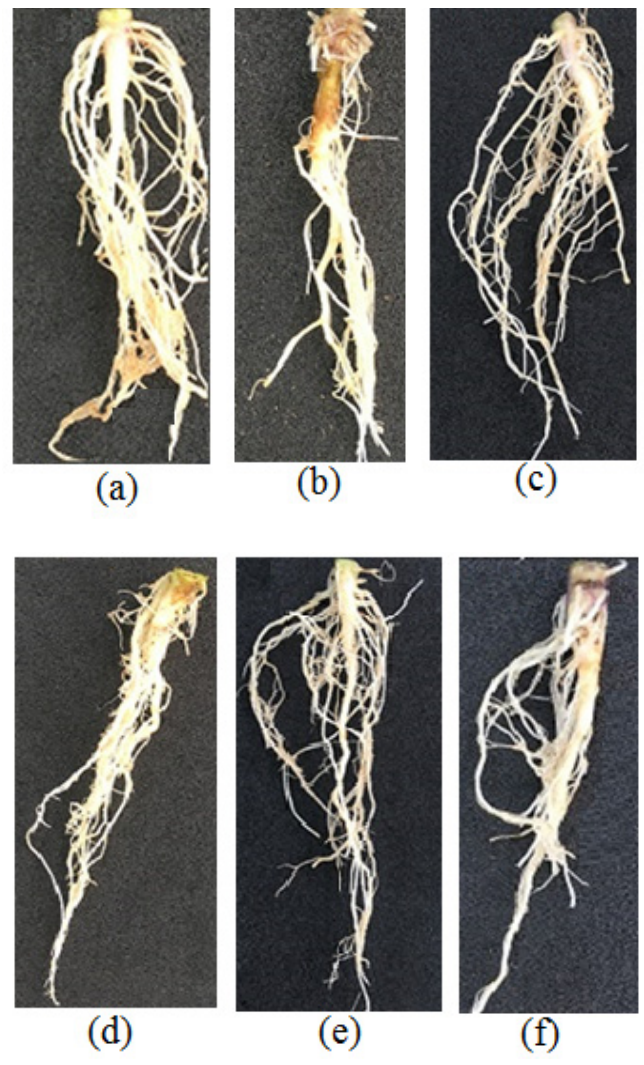
Figure 7. Comparative results of the biological activity of Streptomyces globisporus strain F8 and S. praecox strain R7 against R. solani AG4 on tomato seedlings at the 4th day after pathogen inoculation. ( a ): control treatment; ( b ): plant inoculated with the pathogen alone; ( c , e ): plants inoculated with Streptomyces strains F8 and R7 alone, respectively; ( d , f ): treated seedlings with Streptomyces strains F8 and R7 and pathogen showed smaller lesions than pathogen